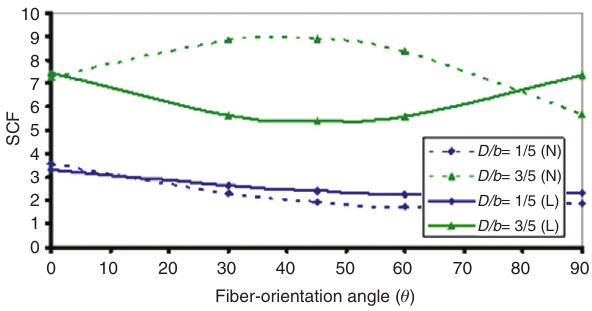
Figure 13 Effect of fiber orientation angle ( θ ) on SCF for a / b = 2 using boron/epoxy